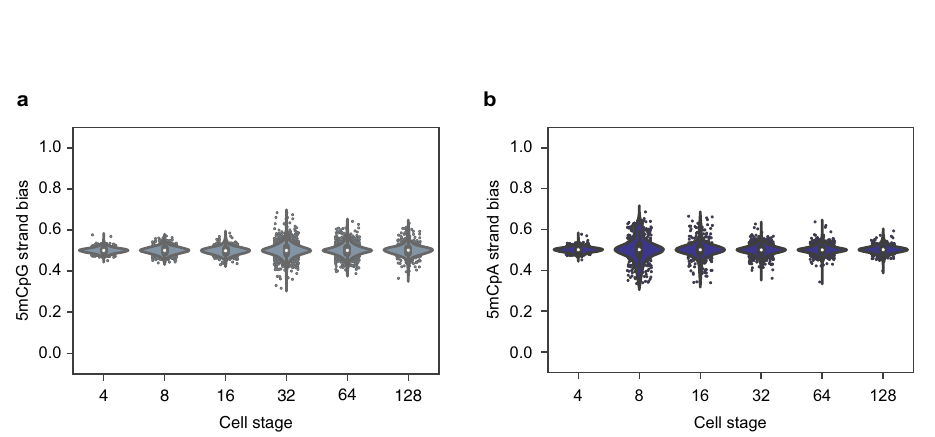
Fig. 4 DNA demethylation dynamics in preimplantation mouse embryos. a Violin plots of 5mCpG strand bias for both the maternal (left) and paternal (right) genome show a tight distribution centered around f = 0.5 till the 16-cell stage and a wider distribution at the 32-cell stage of development ( n = 332 single cells from 42 embryos). b For the maternal genome (left), 5mCpA strand bias shows a bimodal distribution at the 2-cell stage that moves towards a tight unimodal distribution by the 32-cell stage of development. The paternal genome (right) shows a unimodal distribution centered at f = 0.5 throughout preimplantation development till the 32-cell stage ( n = 332 single cells from 42 embryos). In panels ( a , b ), the white dot indicates the median, the black bar indicates the fi rst and third quartile, and the whiskers indicate the minima and maxima. c t-SNE map displaying two clusters of single cells at the 32-cell stage. These clusters were identi fi ed by k -means clustering on the 5mCpG strand bias for all paternal chromosomes (left). The right panel shows the strand bias variance within each cell superimposed on the t-SNE map. d The two clusters shown in panel ( c ) display dramatically different 5mCpG strand-bias distributions — one cluster (left) shows a unimodal distribution while the other cluster (right) shows a bimodal distribution implying loss of methylation maintenance. e Strand bias of chromosomes between anti-correlated cell pairs suggesting that these pairs are sister cells. f Bulk hairpin bisul fi te sequencing reveals that the fraction of CpG dyads that are symmetrically methylated drops substantially from the 16- to 32-cell stage of development ( n = 2 biologically independent bulk samples). Error bars represent the genome-wide standard deviation from the mean methylation maintenance.